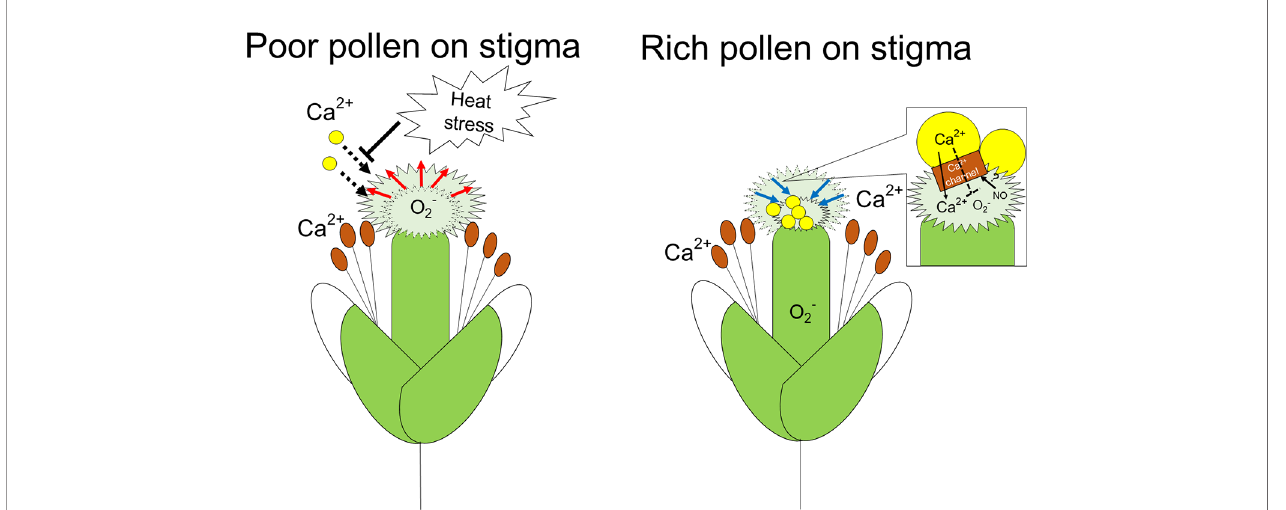
FIGURE 7 | A scheme of putative mechanisms regulating development of stigma with poor or rich pollinations. When pollen attachment is poor, enlargement of stigma via elongation of stigmatic papillae might be activated by the functions of O 2- as a signaling molecule. In contrast, when many pollen attached to the stigma, Ca 2+ signaling derived from pollen might function to reduce the size of stigma via shrinkage of papilla cells. NO might activate calcium permeable channel to assist Ca 2+ entry into the stigma. Decrease of O 2- accumulation in stigma might be induced by Ca 2+ signaling. Spread of O 2- distribution to style and ovary might be associated with processes of pollen-pistils interaction following the attachment of pollen to the